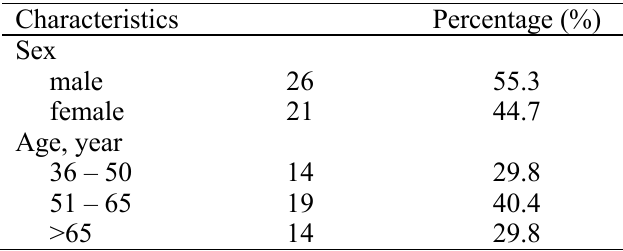
Table 1. Subject characteristics